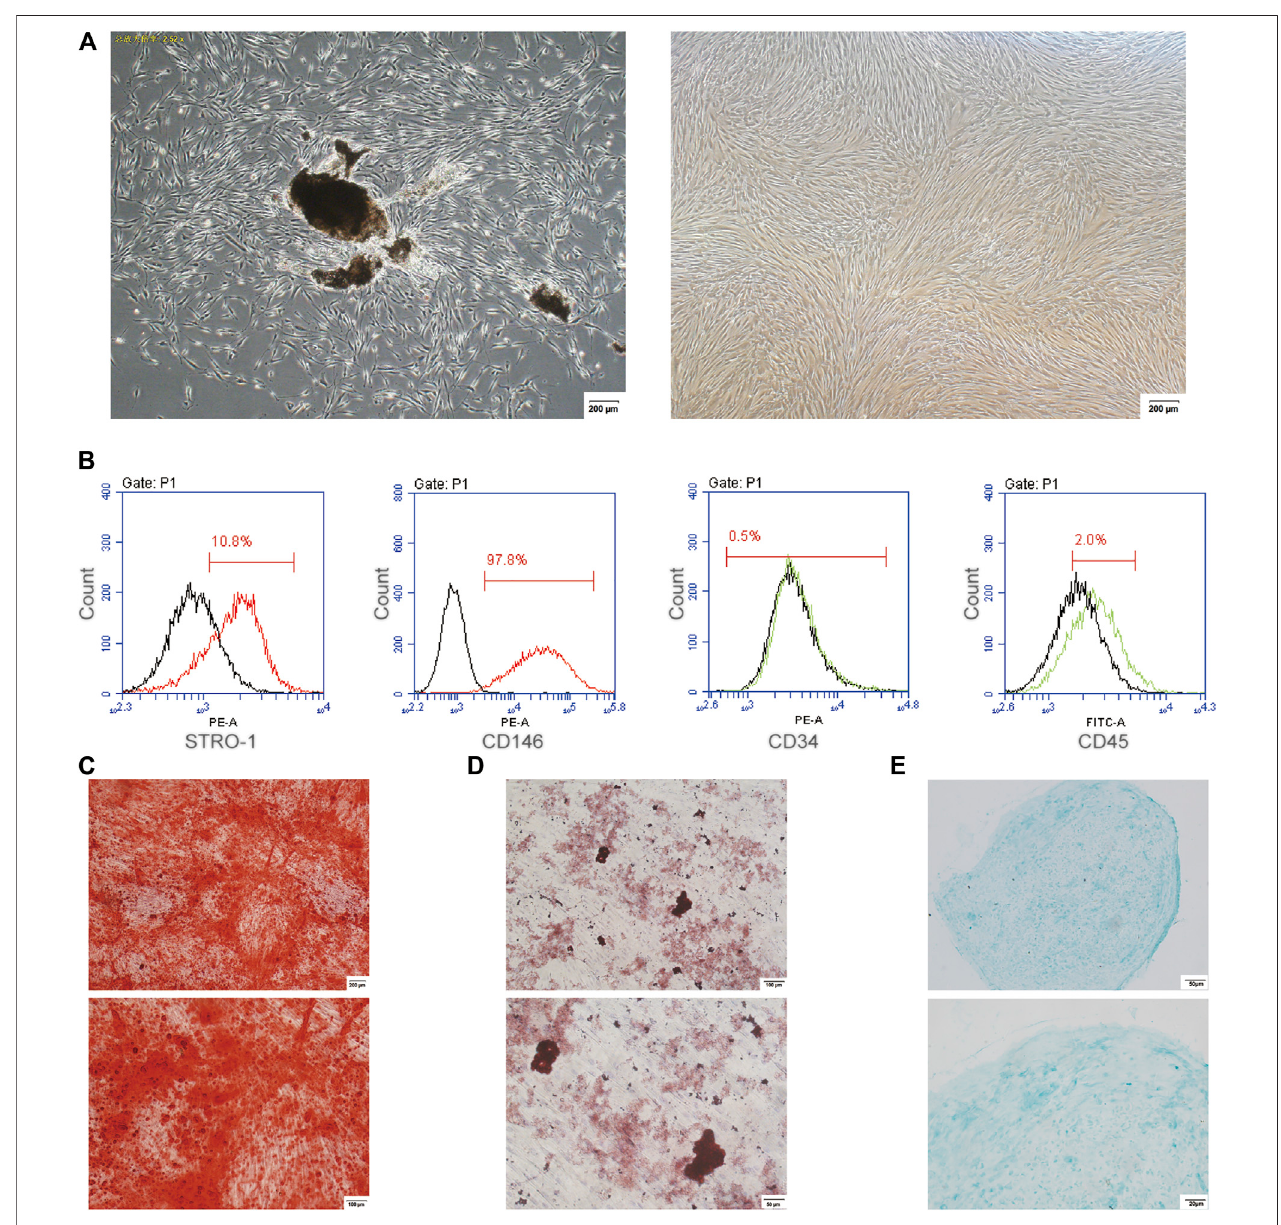
FIGURE 1 | The culture and identi fi cation of PDLSCs. (A) The cultured PDLSCs, isolated from the human periodontal ligament tissues and passaged at 6, with a morphologyoffusiform.Thescalebars,200 µm. (B) FlowcytometrydatashowedthepositiveexpressionforSTRO-1andCD146,andthenegativeexpressionforCD34 andCD45inPDLSCs. (C) Alizarinredstaining.Thescalebars,100and200 µm. (D) OilredOstaining.Thescalebars,50and100 µm. (E) Alcianbluestaining.Thescale bars, 20 and 50 µm.